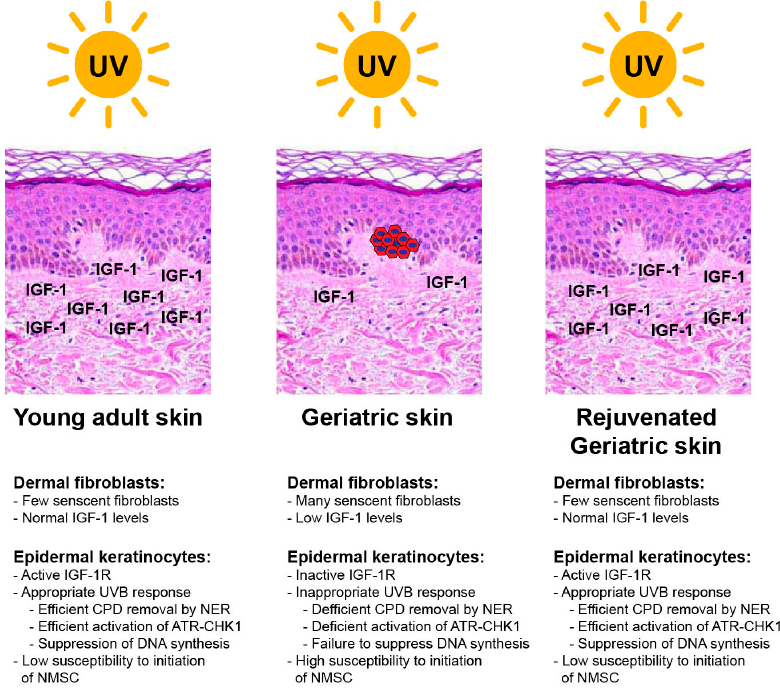
Figure 3. Model for the effects of age and IGF-1 status on fibroblast and keratinocyte behavior in UVB-irradiated human skin. (Left panel) In young adult skin, dermal fibroblasts produce IGF-1, which leads to active IGF-1Rs on keratinocytes in the epidermis. Thus, when these keratinocytes are exposed to UVB, they carry out an appropriate response, which includes efficient nucleotide excision repair (NER), activation of ATR-CHK1 signaling, and the suppression of DNA synthesis. Together, this appropriate response is associated with a low susceptibility to NMSC initiation. (Middle panel) In contrast, in geriatric skin containing many senescent fibroblasts, the reduced production of IGF-1 leads to inactive IGF-1Rs in epidermal keratinocytes. Exposure of these cells to UVB leads to an inappropriate response that includes deficiencies in NER, ATR-CHK1 signaling, and in the suppression of DNA synthesis, which may culminate in mutagenesis and a higher susceptibility to initiate NMSC. (Right panel) Geriatric skin treated with dermal rejuvenation intervention behaves similar to that of young adult skin.